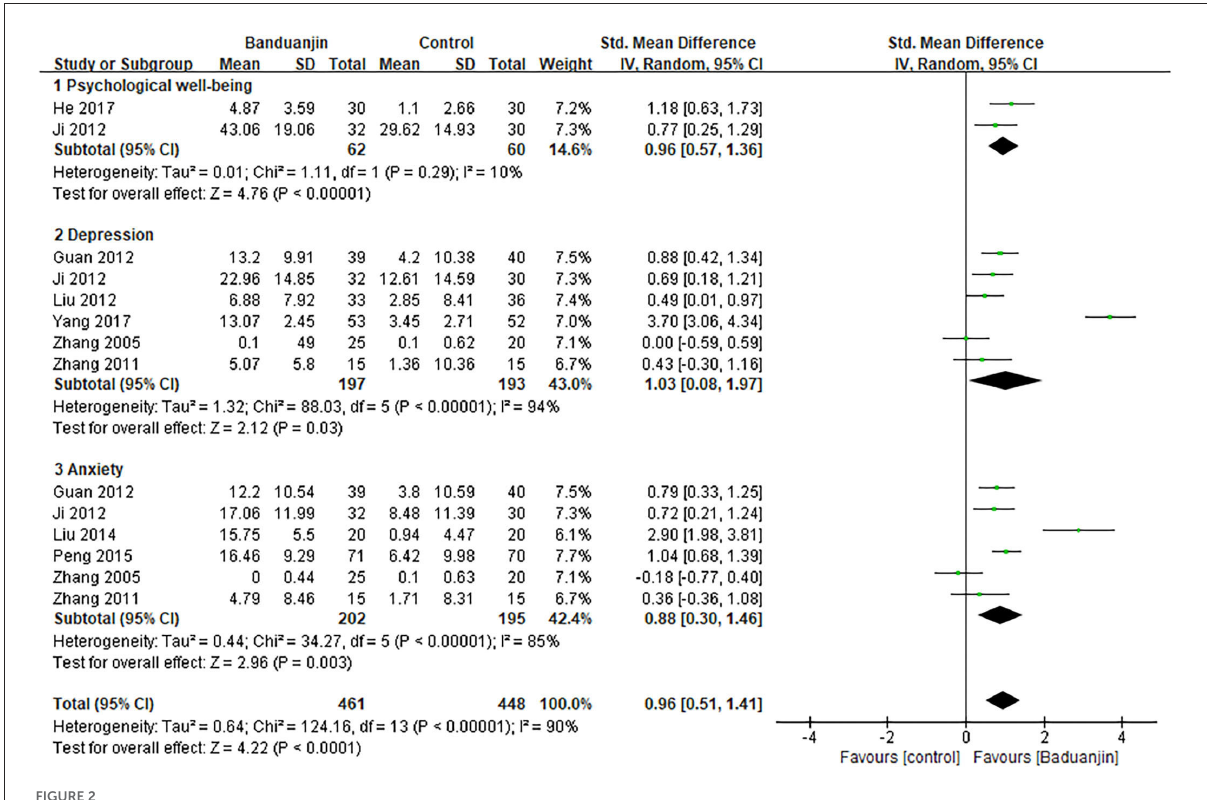
FIGURE2 Forest plot of the effects of Baduanjin exercises on psychological